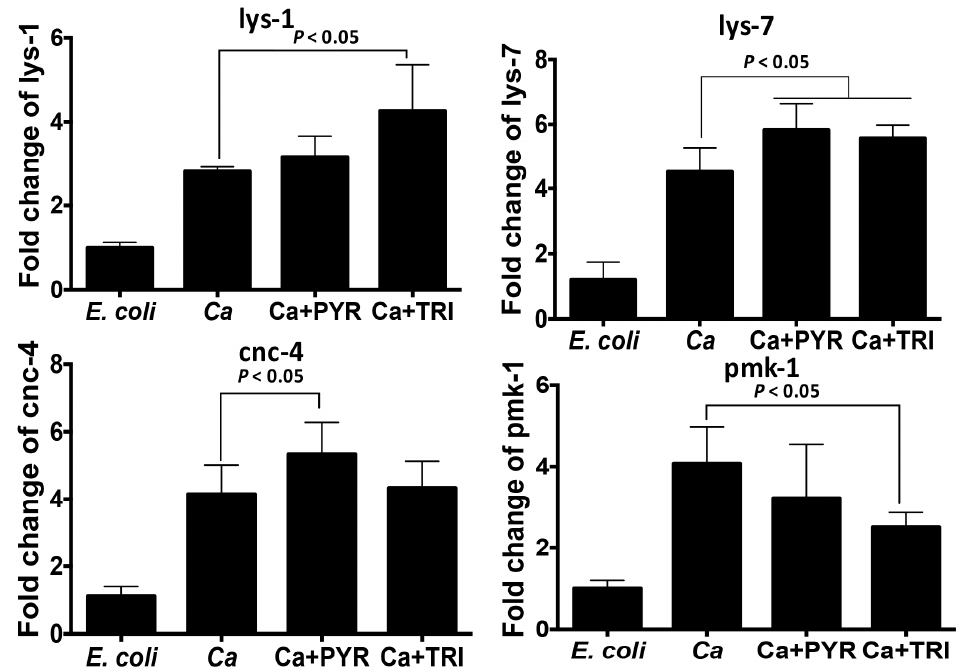
Figure 7. Relative expression of antimicrobial peptides (lys-1, lys-7, and cnc-4) and the immune gene (pmk-1) in C. elegans infected with C. albicans . L4 nematodes were infected with C. albicans SC5314 lawns for 6 h and then treated with PYR or TRI at their 1x MIC for 12 h. E. coli represents C. elegans fed with E. coli . Ca represents C. elegans infected with C. albicans . Ca + PYR corresponds to C. elegans infected with C. albicans and treated with PYR. Ca + TRI represents C. elegans infected with C. albicans and treated with PYR. Data are presented as mean ± SD of four independent measurements.